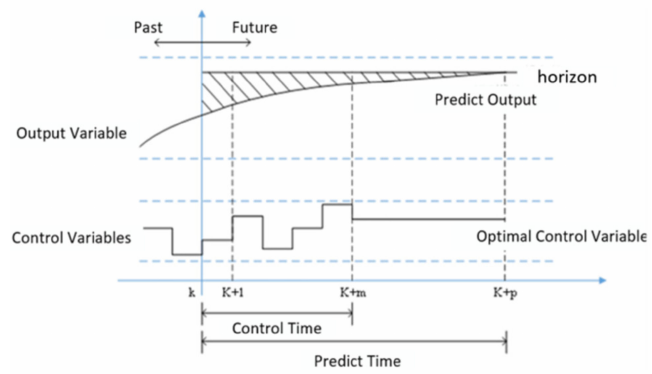
Figure 2. Model Predictive Control